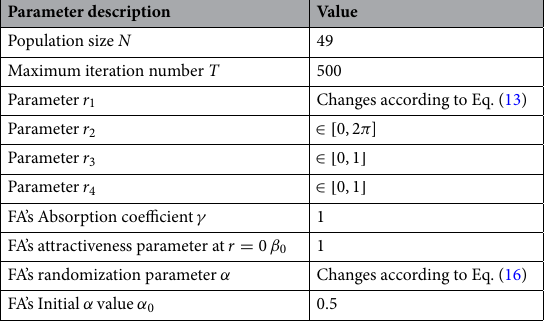
Table 1. Control parameter summary.